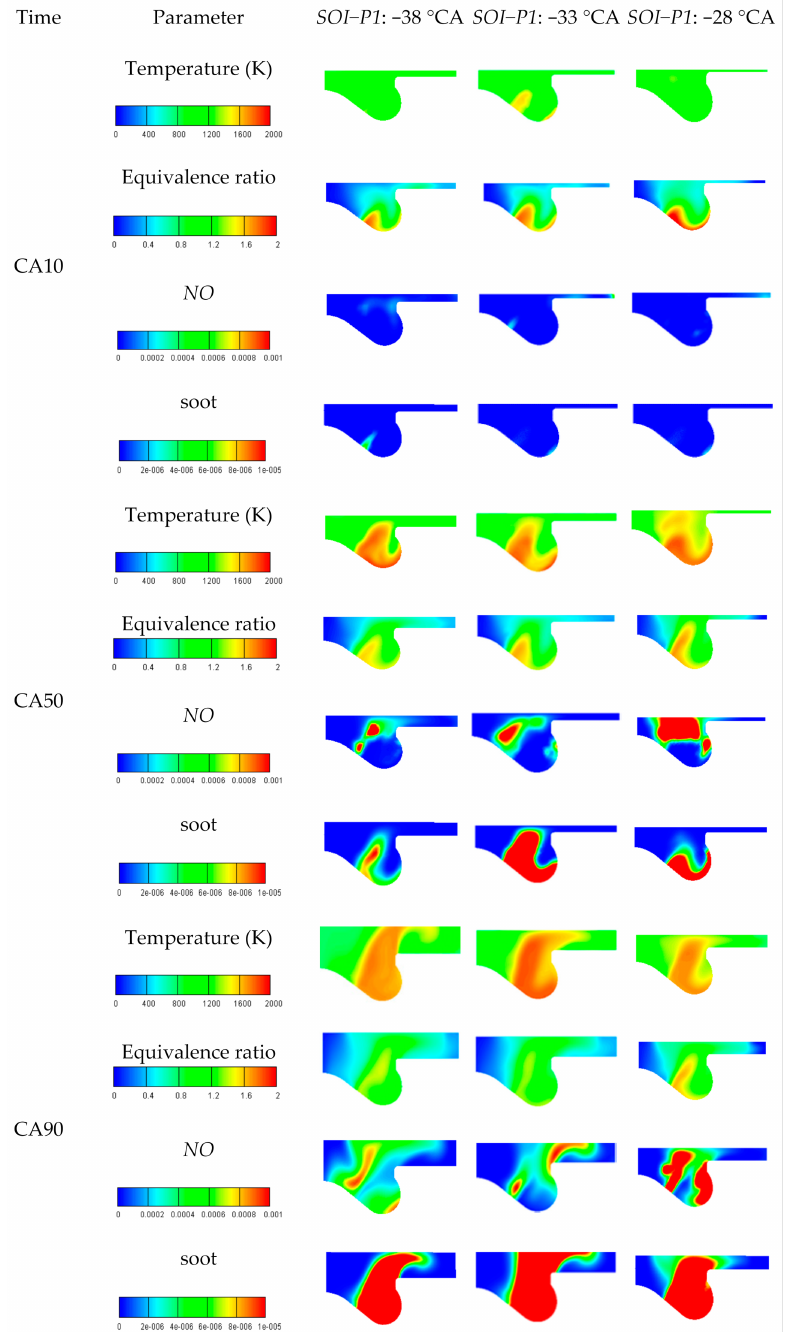
Figure 7. Temperature, fuel-air equivalence ratio, NO , and soot graphs for diverse SOI − P1 schemes in